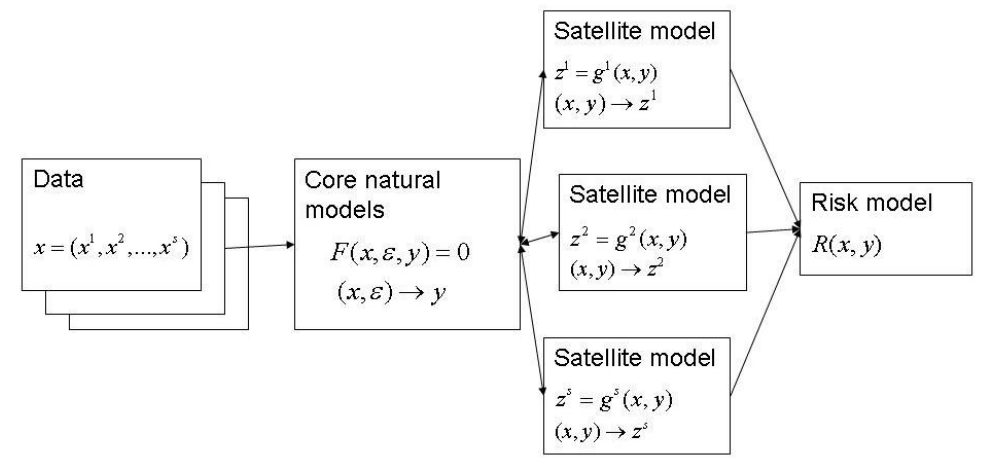
Fig. 1. Multi-model approach to socio-ecological risks